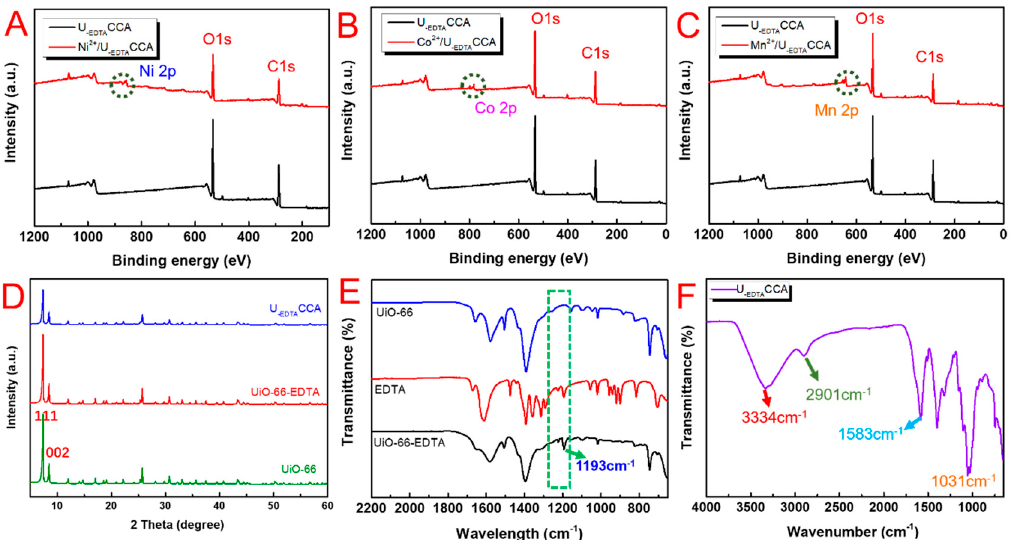
Figure 4. ( A – C ) Comparison of the wide-scan XPS spectra of the U -EDTA CCA loaded with heavy mental ions; ( D ) XRD patterns of UiO-66, UiO-66-EDTA, and U -EDTA CCA; ( E ) FTIR spectra of UiO-66, EDTA, and UiO-66-EDTA; and ( F ) FTIR spectra of U -EDTA CCA. Table 1. Comparison of the adsorption of metal ions of U- EDTA CCA with other adsorbents.